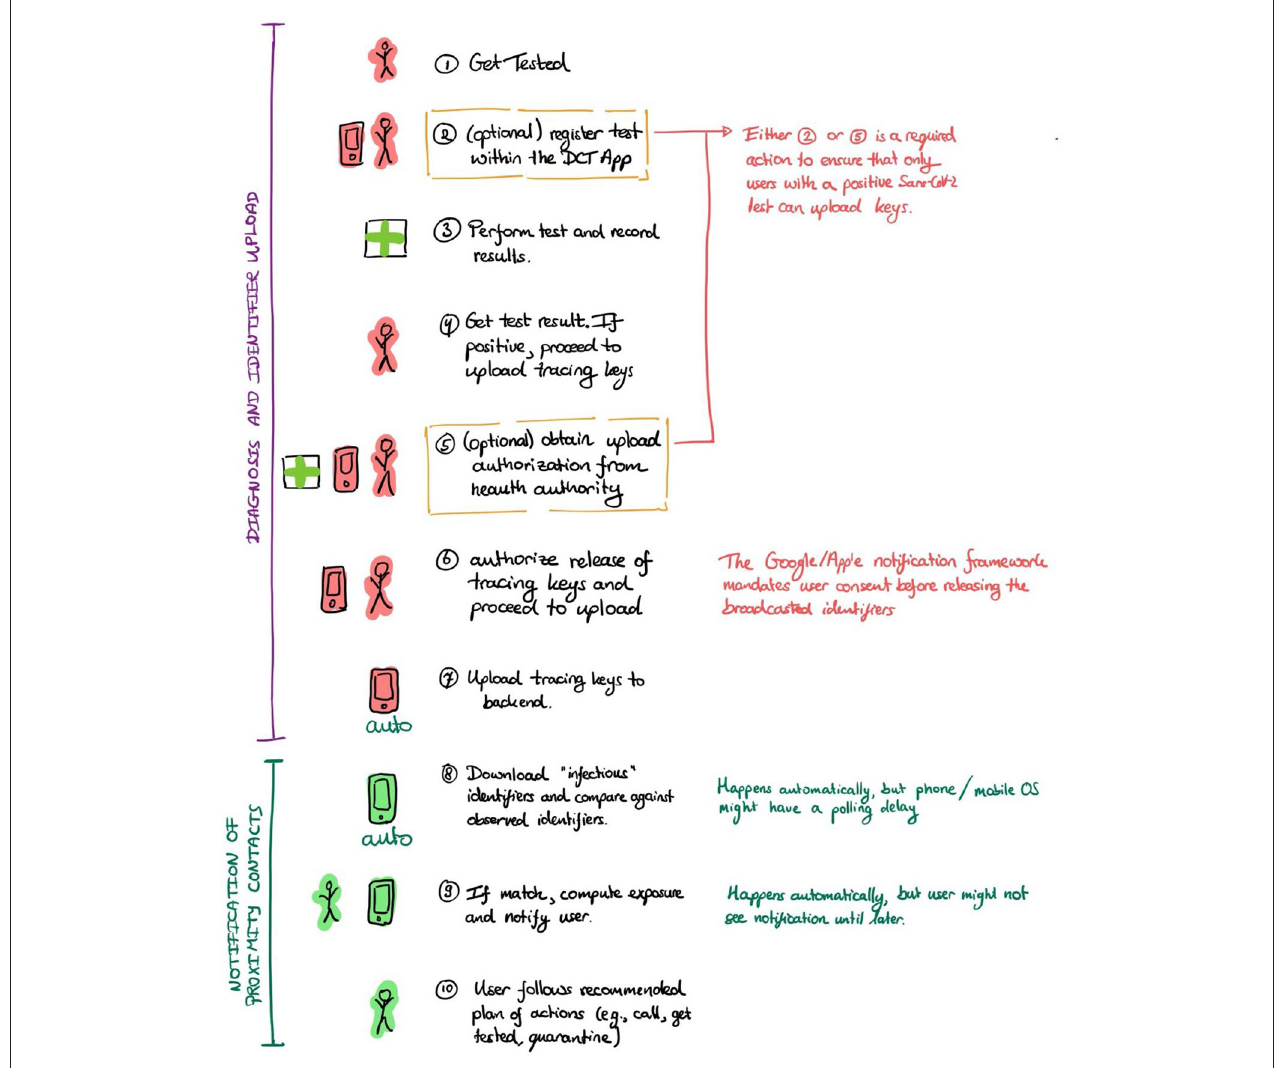
FIGURE 2 | Specific actions required in the notification